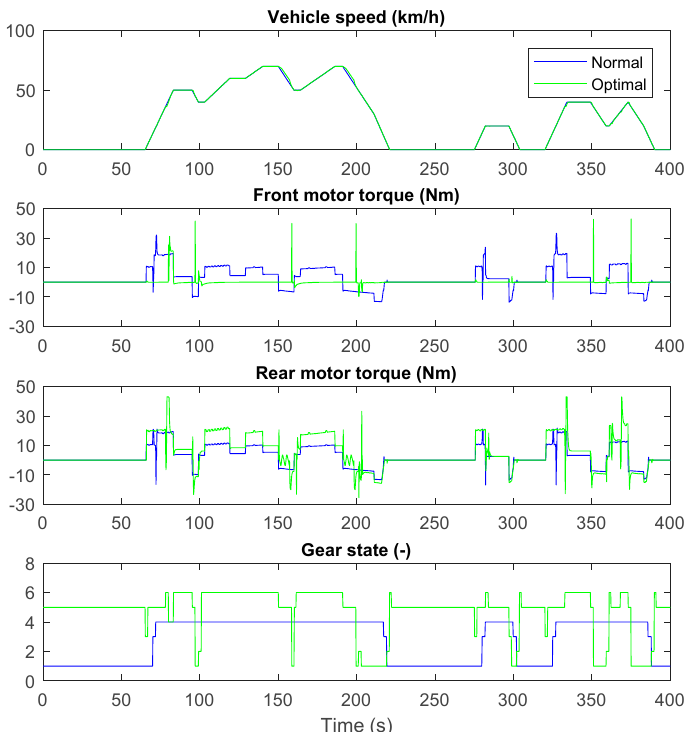
Figure 15. Time profiles of EV speed, front and rear motor torque, and gear state, for the 2-speed 4WD EV layout (L4) during a section of the J10–15 cycle. Table 6. Energy consumption results along the selected driving cycles, and their percentage difference with respect to those of the single-speed 2WD EV (L1); negative differences, implying lower consumption, are in green.